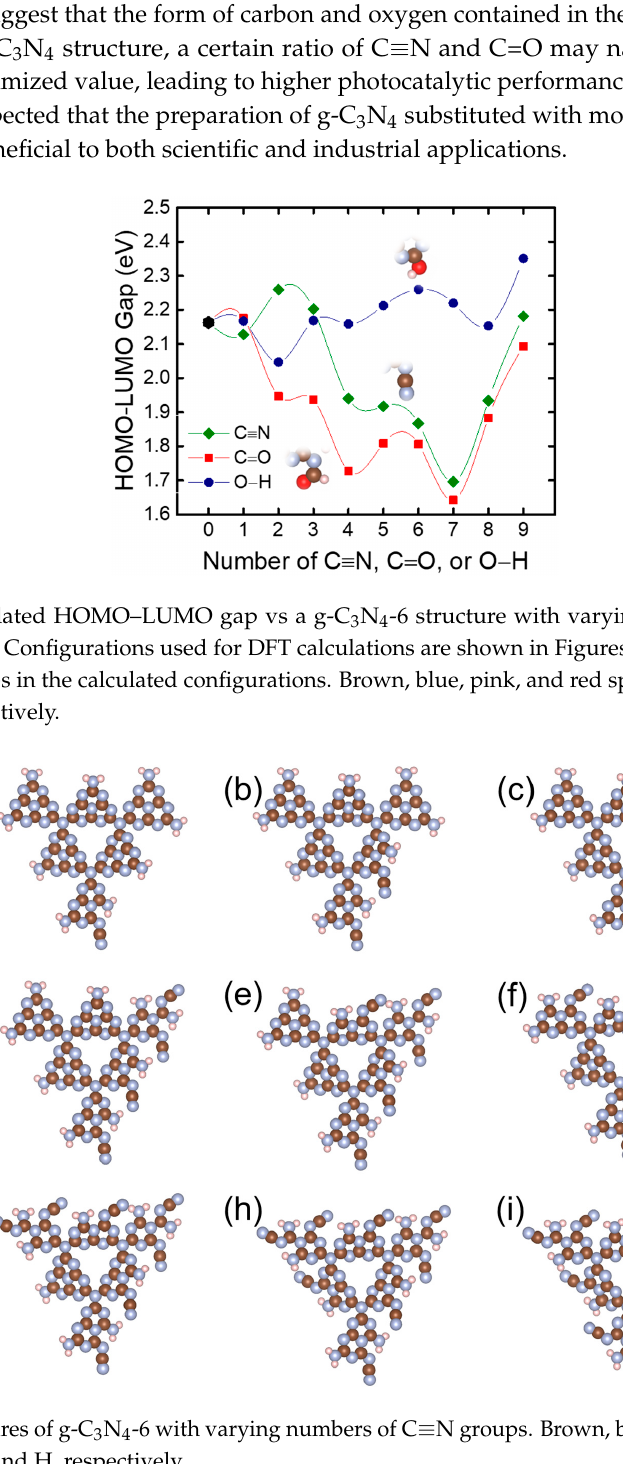
Figure 4. Structures of g-C 3 N 4 -6 with varying numbers of C=O groups. Brown, blue, pink, and red spheres represent C, N, H, and O, respectively.